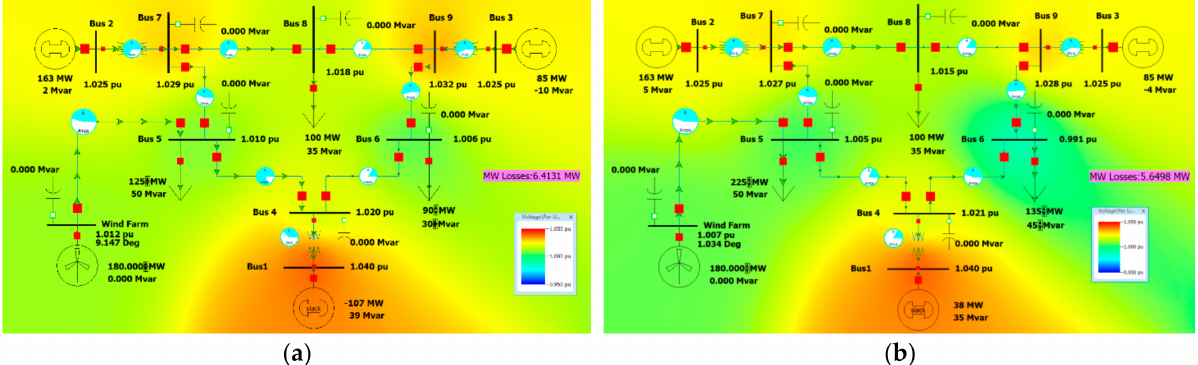
Figure 2. Simulation results with Tower B connected to bus 5 (25 km). ( a ) The results under the minimum load condition and ( b ) the results under the maximum load